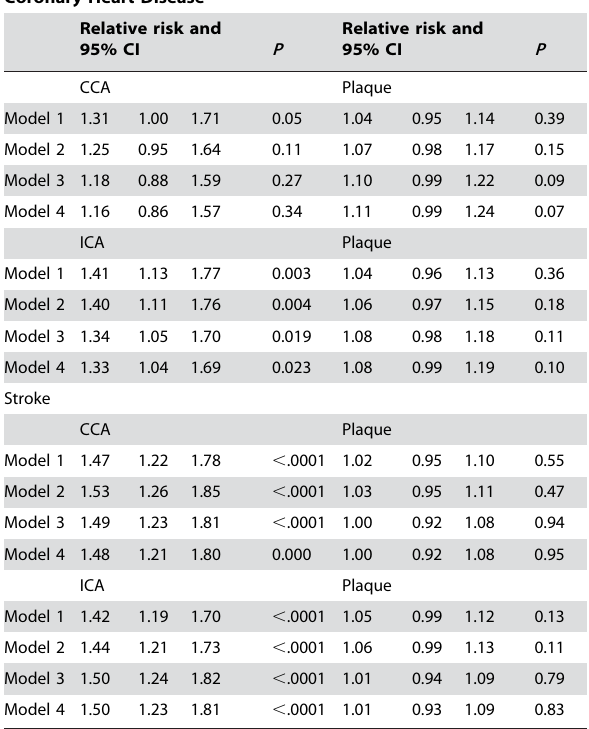
Table 4. Relative risk and 95% confidence intervals for jointed analysis of per 1 SD increase in IMT and 1 score increase in plaque score for CHD and stroke.